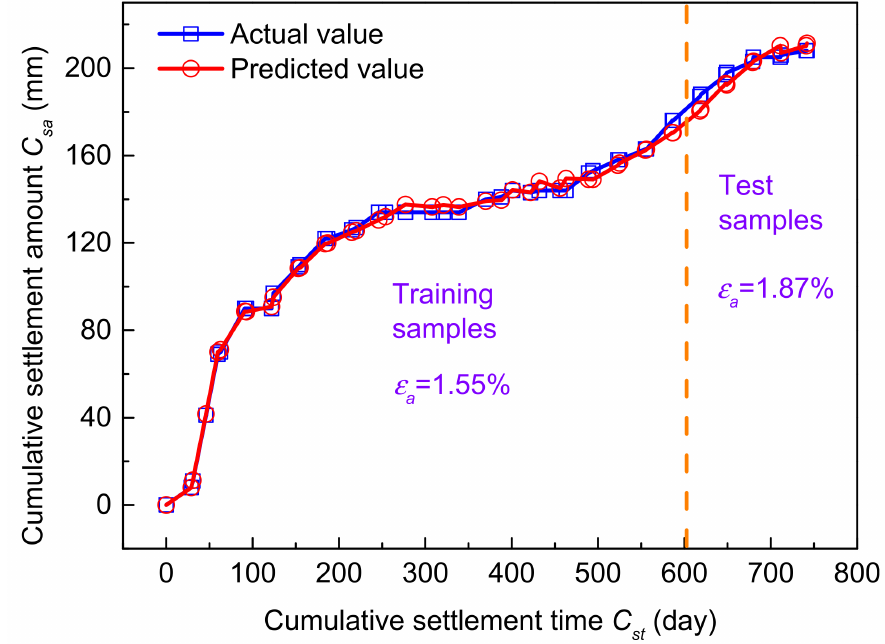
Figure 4. Comparison between predicted and actual value of soft soil settlement of training samples and test